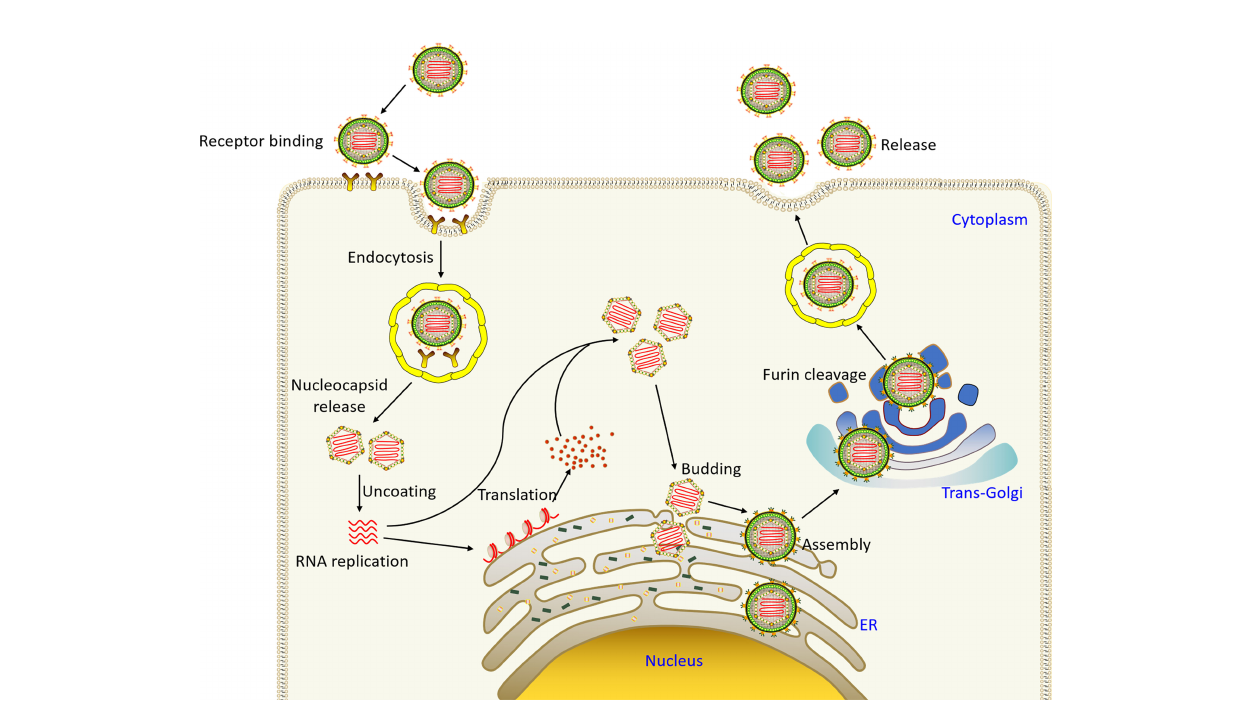
FIGURE 2 | The fl avivirus life cycle. Virus particles bind to receptors on the surface of the host cell membrane and enter the cell through endocytosis. The acid environment of endosomal vesicle induces the conformational changes of virus particles, and the fusion of virus and vesicle membrane leads to the release of virus particles. Subsequently, the viral genome is released into cytoplasm, and the positive-sense RNA is directly translated into a polyprotein, which is cleaved and processed by the virus and host proteases. Virus assembly occurs on the surface of the ER, and then non-infectious, immature virus particles carrying prM and E are transported to trans-Golgi network (TGN). The host protease furin then cleaves prM to M, producing mature infectious particles. Eventually mature virus particles are released by exocytosis